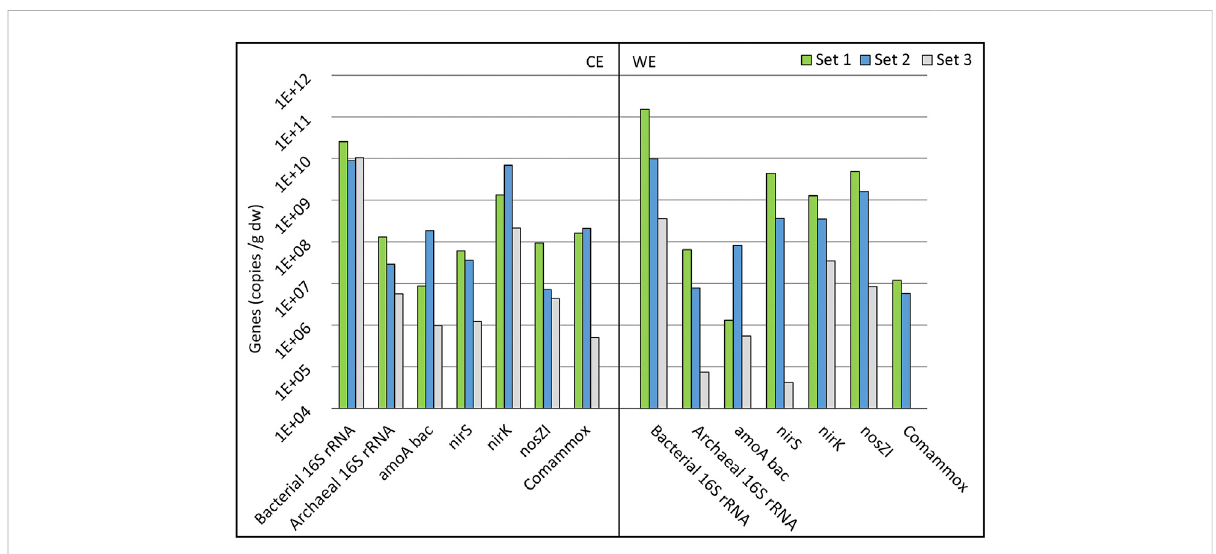
FIGURE 7 Geneabundancesofelectrodesets1 – 3onalogarithmicscale.CounterelectrodedataareshownintheCEsection,andworkingelectrodedata are shown in the WE section. See Chapter 3.5 for the explanation of gene symbols and electrode names.